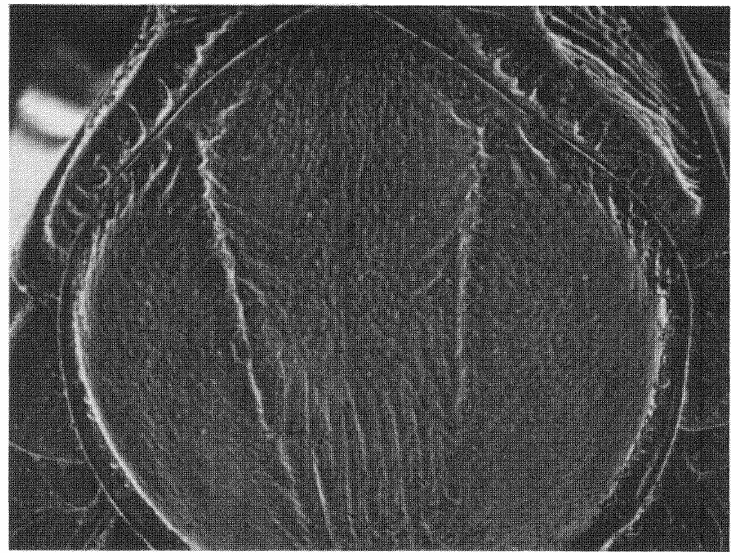
Fig. 6. Cosmiocryptus violaceipennis, pronotum and most of mesoscutum in dorsal view.